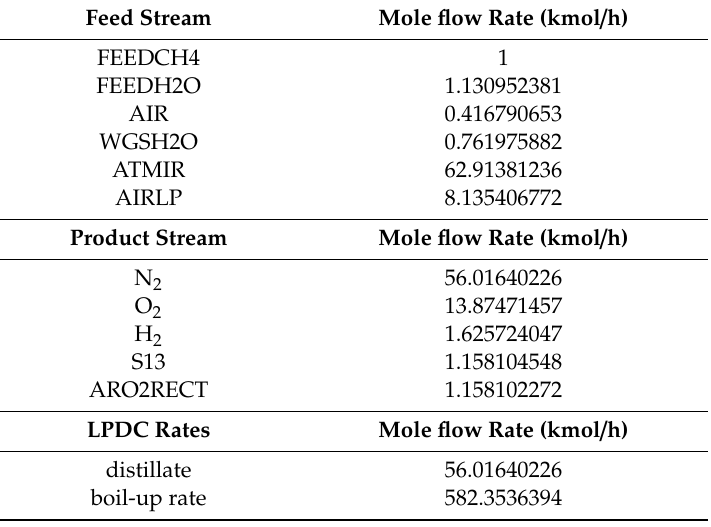
Table 5. ASU-SMR-WGS-PSA-CCS-HXGT mole flow rates for 1 kmol / h of